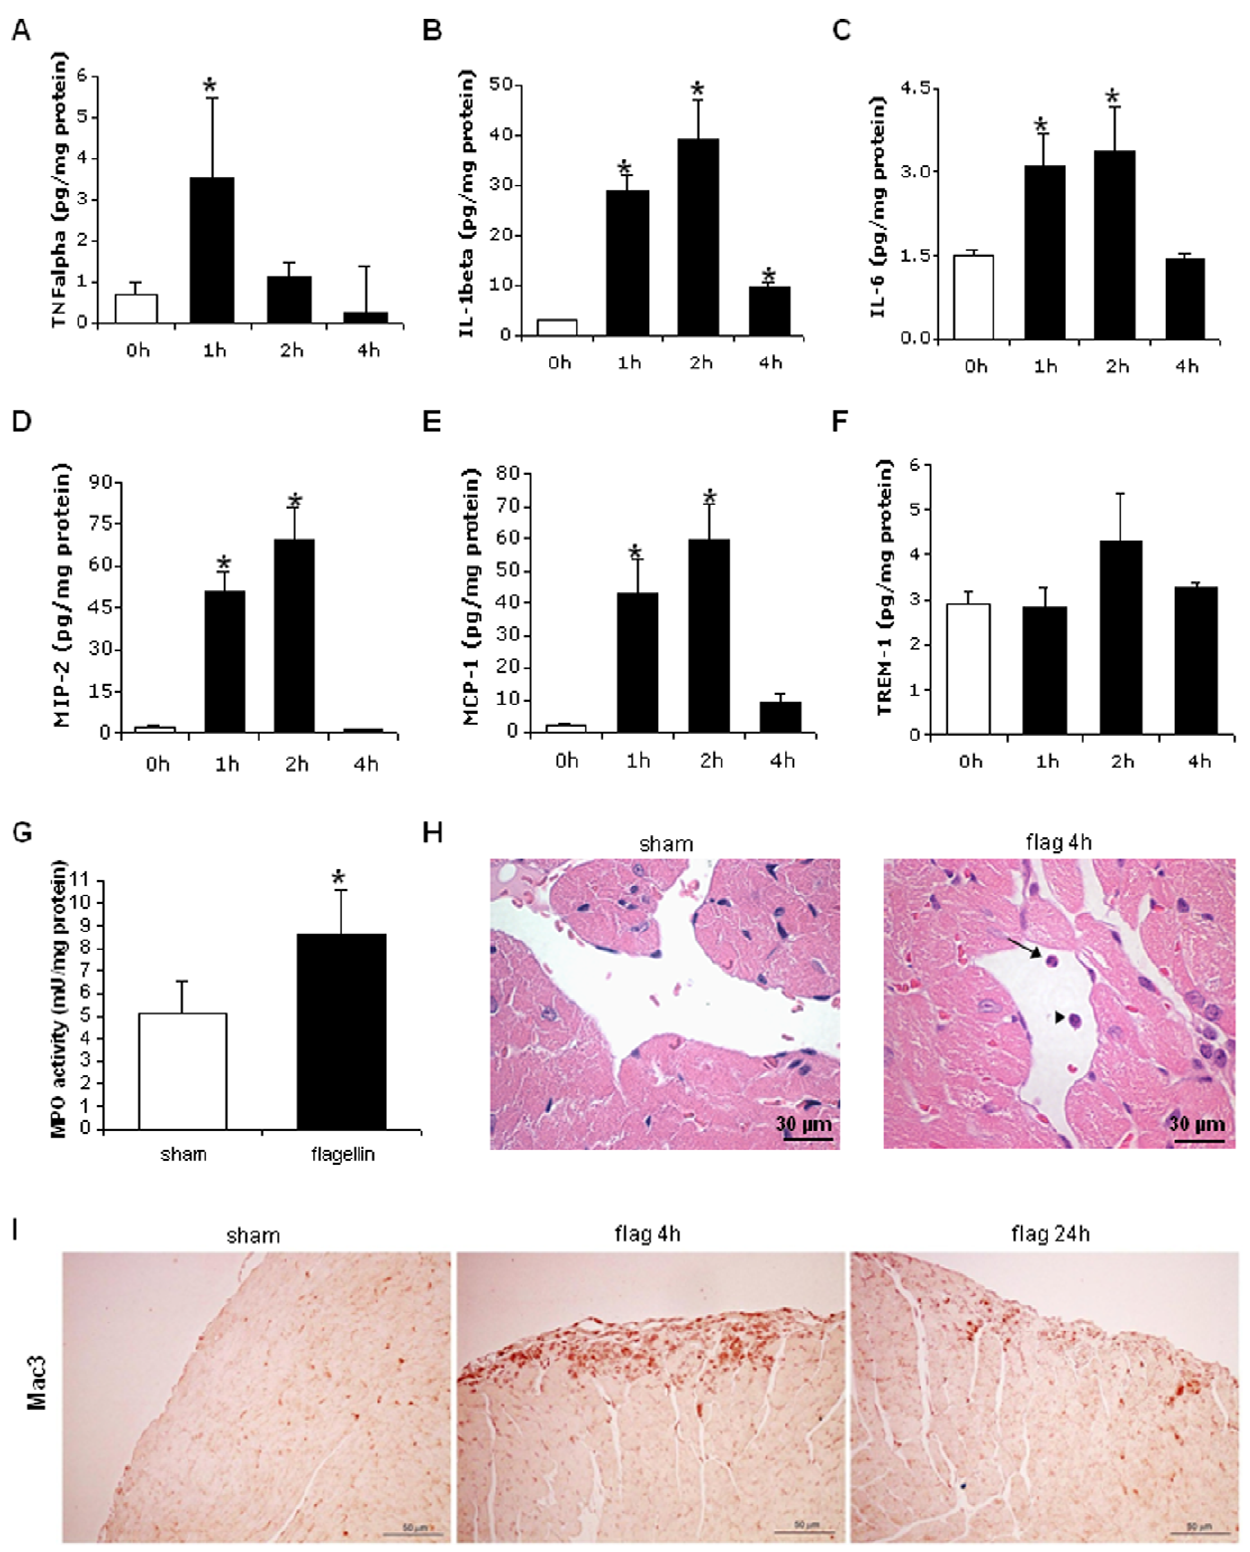
Figure 7. Flagellin triggers the generation of pro-inflammatory cytokines in the mouse heart in vivo. Flagellin (1 m g) induced significant increases of TNF-, IL-1, IL-6, MIP-2 and MCP-1 (A–E), but not soluble TREM-1 (F) in whole hearts from BALB/c mice (n=5 mice per condition). Flagellin also induced a modest, but significant increase of myeloperoxydase (MPO) activity in the heart after 4 h (G). Histologically, rare polymorphonuclear (arrow) and mononuclear (arrowhead) leukocytes were found within cardiac blood vessels (H). Immunohistochemical studies revealed a slight recruitment of Mac-3 positive mononuclear cells, located in the subepicardial region (I). * p , 0.05 versus control C (ANOVA followed by Dunnett test A to F; t -test, G). Histological pictures are representative of 3 mice/group. Scale bar size: 30 m m (H); 50 m m (I). doi:10.1371/journal.pone.0012687.g007 PLoS ONE |